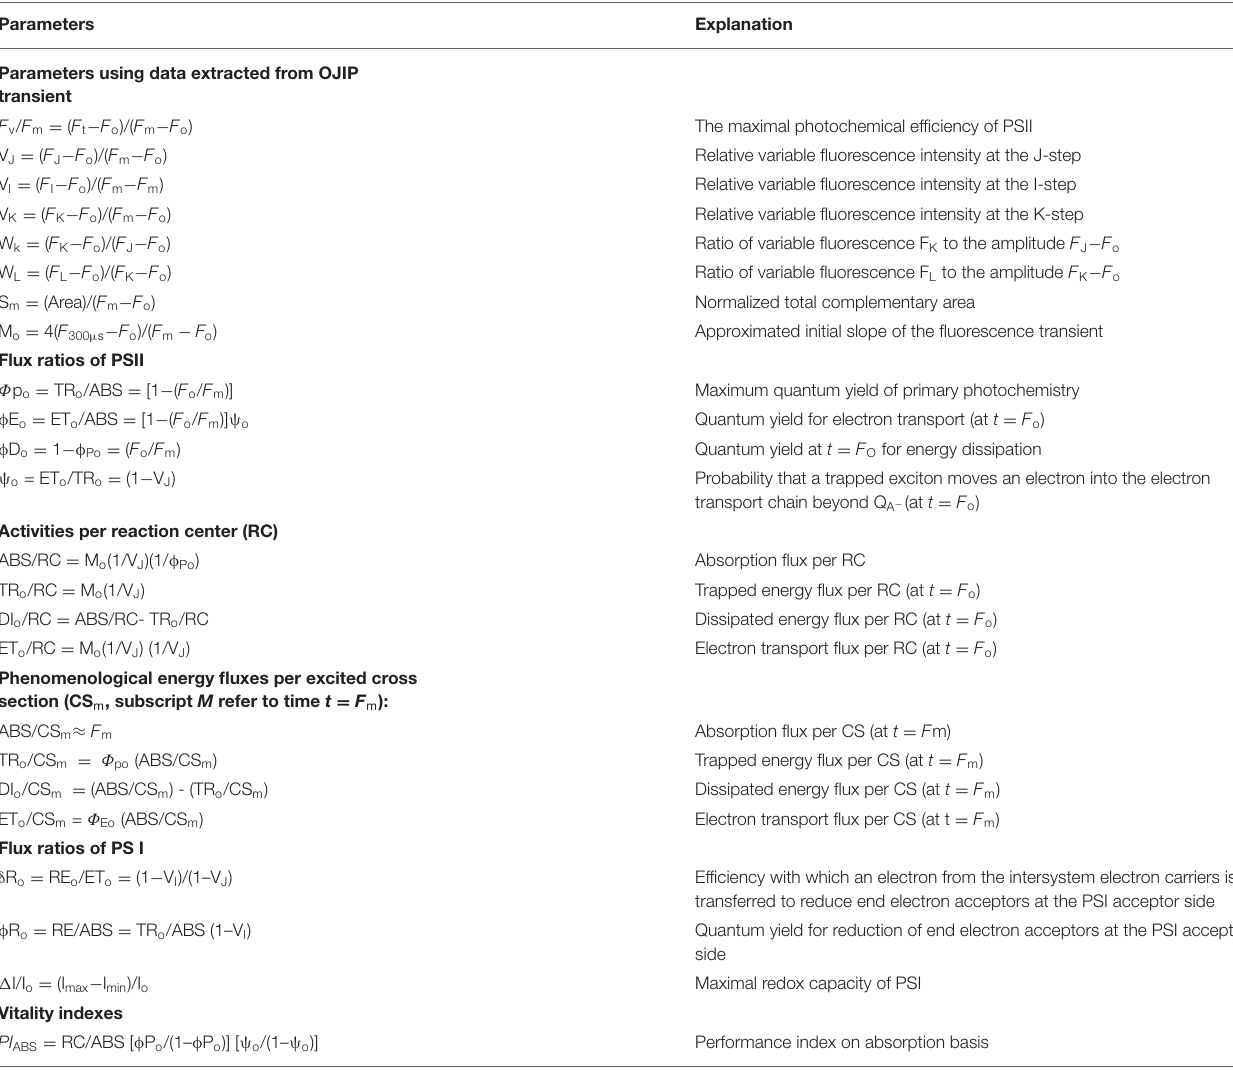
TABLE 1 | Summary of parameters and formulae using data extracted from chlorophyll (Chl) a fluorescence (OJIP) transient.